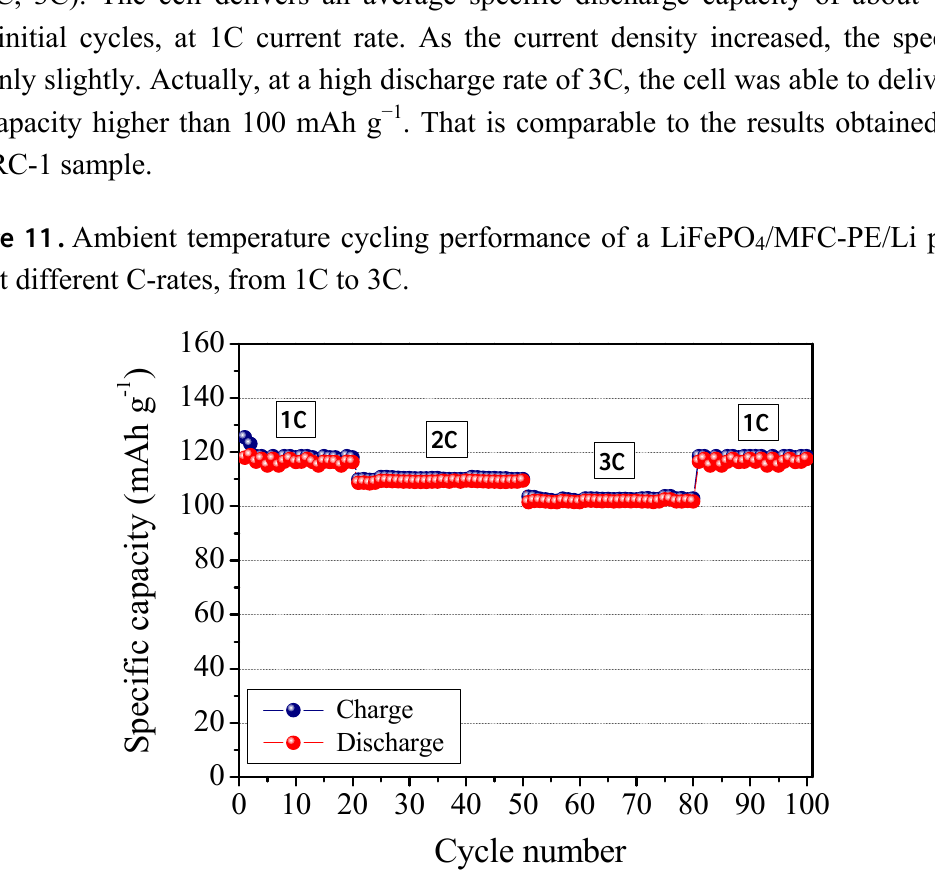
/MFC-PE/Li polymer 4